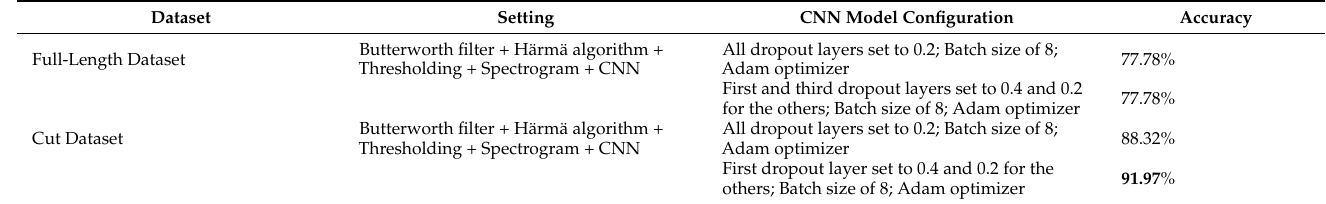
Table 3. Experimental results using the Härmä algorithm and